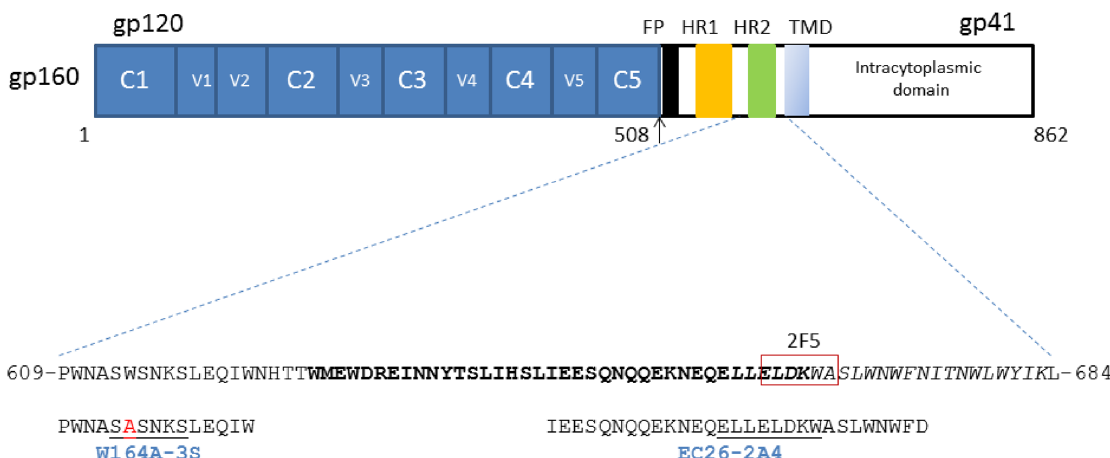
Figure 7. Sequence and location of W164A-3S and EC26-2A4 peptides in the transmembrane glycoprotein of HIV-1 (gp41, HXB2 reference strain numbering, GenBank: AF033819.3). Epitope sequences are indicated in underlined letters 18,22,52 . The W614A mutation in peptide W164A-3S is shown in red. The amino acid sequence of the heptad repeat 2 (HR2) region is indicated in bold letters (aa 628–665). TMD- transmembrane domain; FP- fusion peptide; HR1- heptad repeat 1. The membrane proximal external region (MPER) is shown in italic letters (aa 660–683) 6,16 . The epitope of the broadly neutralizing antibody 2F5 is boxed 17 . In gp120, V1-V5 are hipervariable regions and C1-C5 are conserved